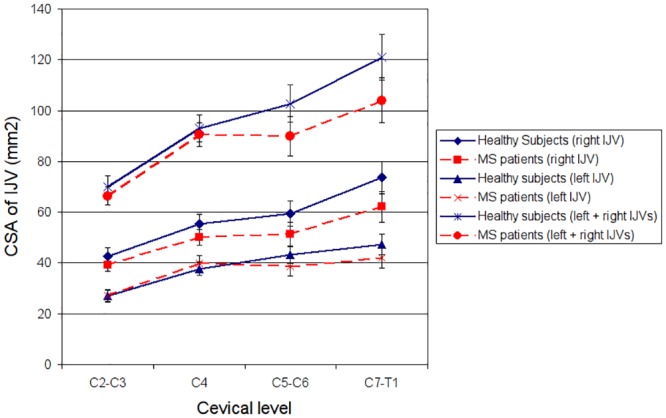
Cross sectional areas (CSAs) of respective left and right internal jugular veins (IJVs) in the MS patients and healthy subjects.(Error bars represent one standard error of the mean.)